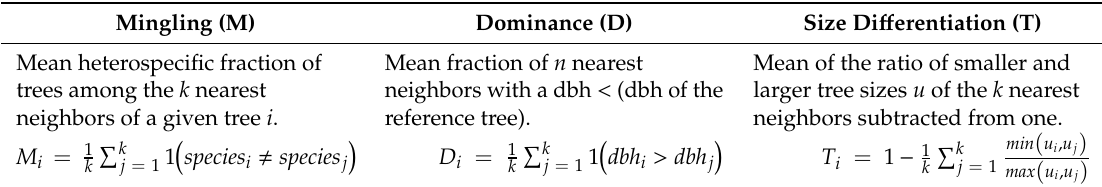
Table 1. Measures of species-specific structural diversity. Mingling (M) Dominance (D) Size Di ff erentiation (T) Mean heterospecific fraction of Mean fraction of n nearest trees among the k nearest neighbors with a dbh < (dbh of the neighbors of a given tree i . reference tree).